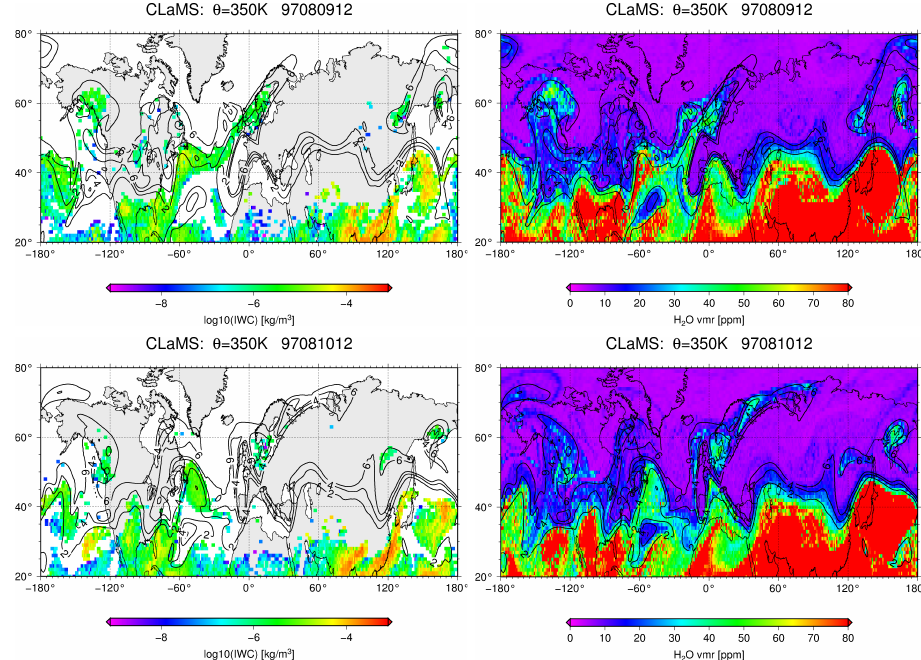
Figure 7. CLaMS model results of IWC (left) and water vapour (right) for meteorological input data based on ERA Interim; top row for 9 August at 12:00 UTC and bottom row for 10 August 1997. CLaMS irregular data are interpolated to a 1 ◦ × 1 ◦ grid for the 350K isentrope.